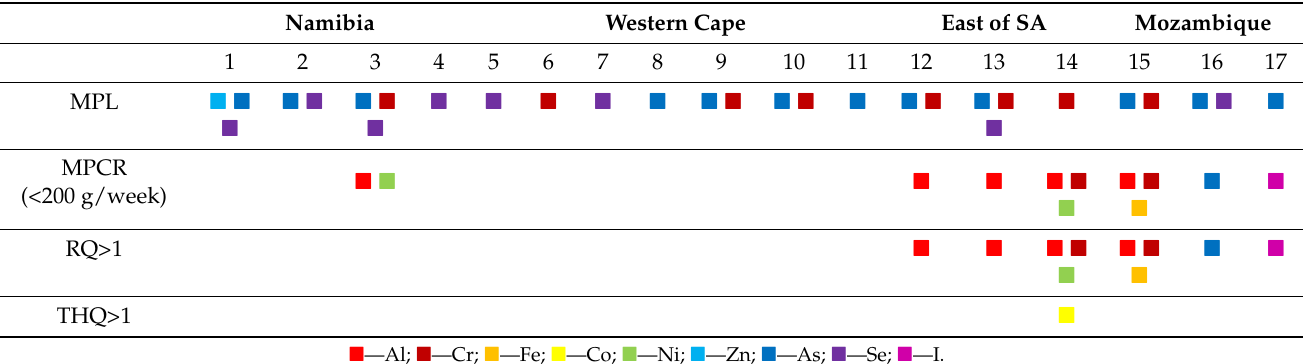
Table 5. Elements with high risks according to 4